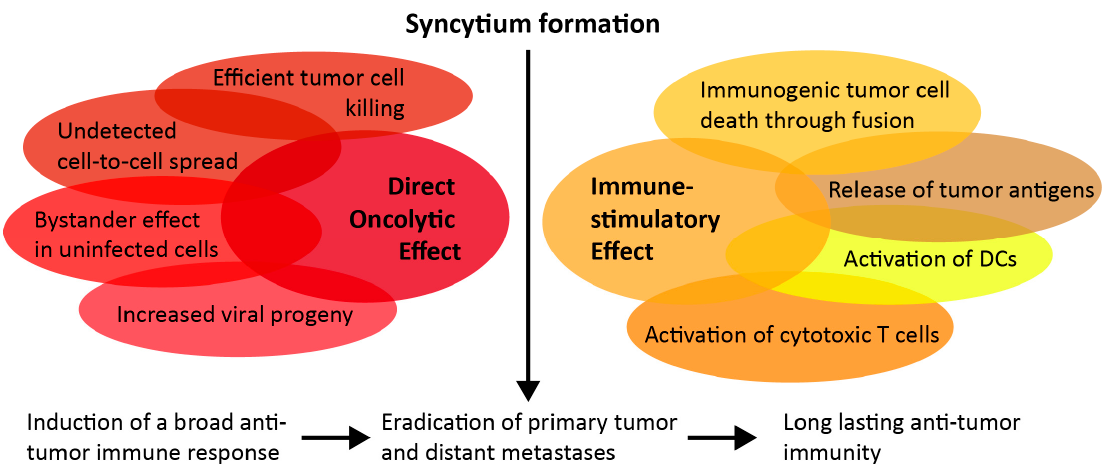
Figure 1. Advantages of syncytia formation for immunotherapeutic approaches. Upon tumor cell infection with a fusogenic oncolytic virus, syncytia form and contribute to an enhanced direct oncolytic effect, resulting in wider spread of the infection and an increased release of viral progeny from a large multinucleated area. Syncytia formation also prompts a broad immune-stimulatory effect. Together with immune-activating cytokines, tumor associated antigens (TAAs) are released from dying syncytia, and are immediately taken up by recruited antigen-presenting cells (APCs) that prime a cytotoxic T-cell response by cross-presentation through dendritic cells (DCs).